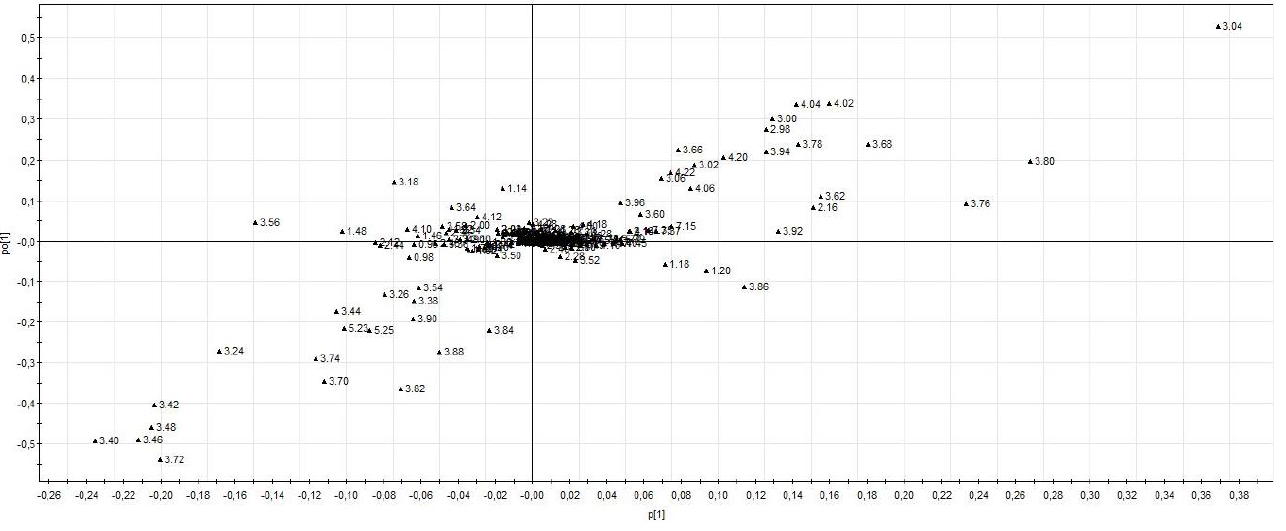
Figure 3. Loadings plot (septic shock versus ICU control group). Different expressions of metabolites between septic shock and ICU control group (R 2 X = 0.53; R 2 Y = 0.58; Q 2 = 0.29).